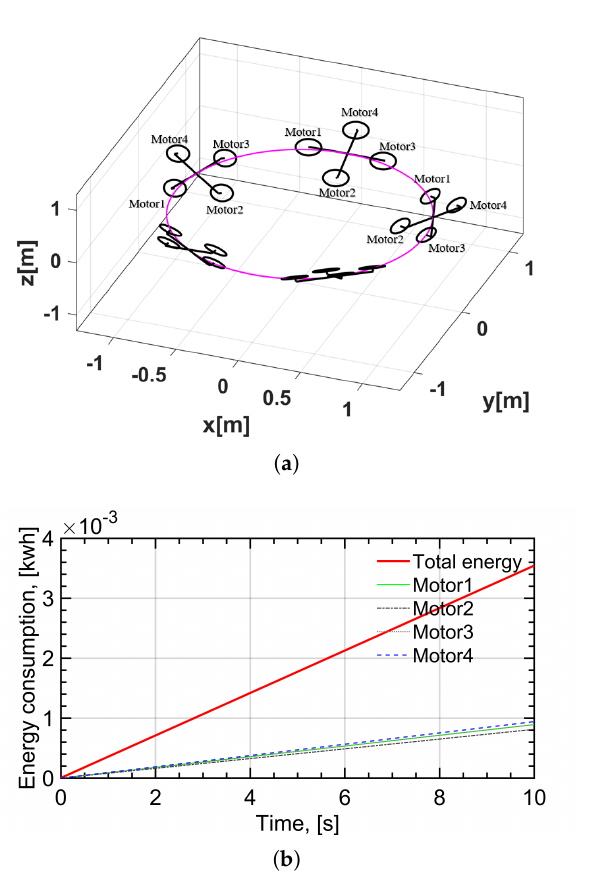
Figure 4. ( a ) An intuitive display of the circular trajectory in horizontal plane. ( b ) Total and single energy consumption of BLDC motors under circular trajectory. The red solid line represents the total energy consumption under circular trajectory. Motor1, Motor2, Motor3 and Motor4 represent the energy consumption of four motors,